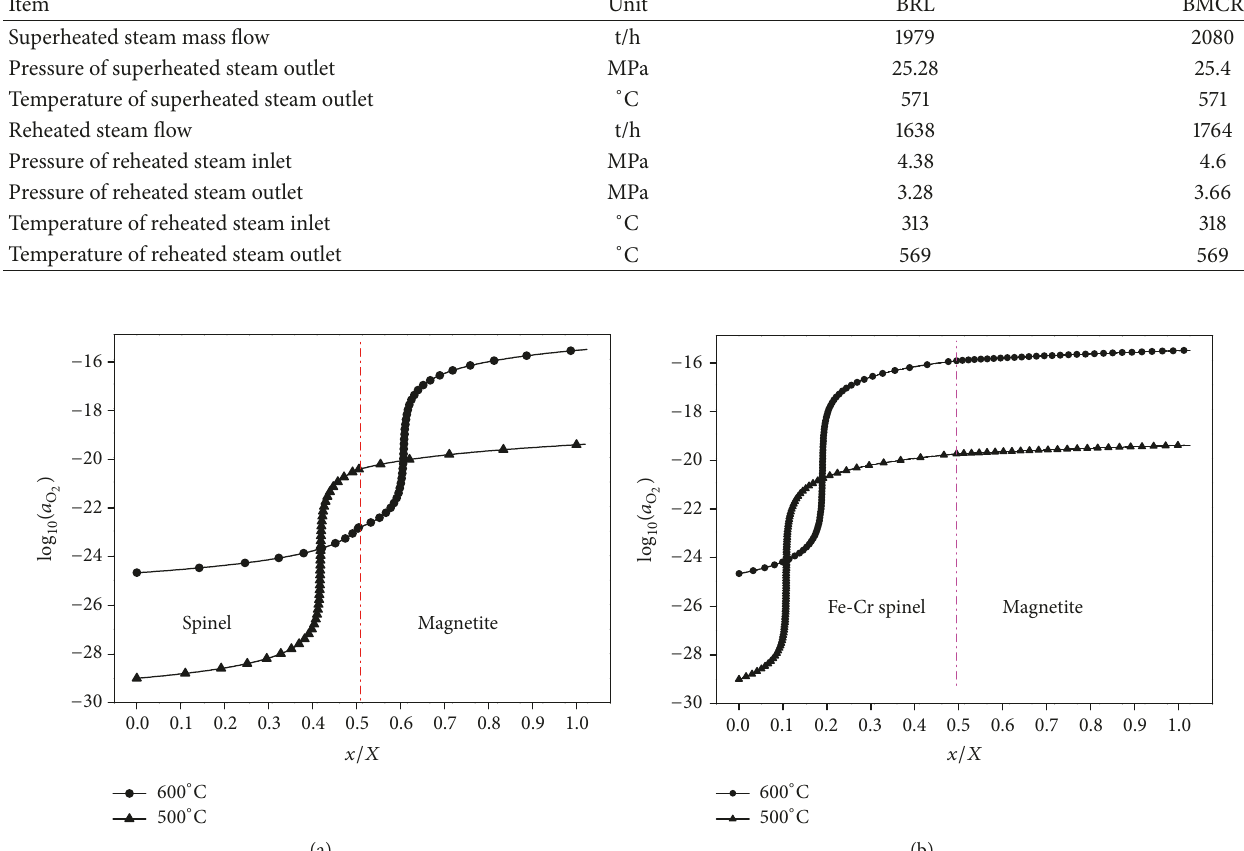
Figure 5: The calculation oxygen activity in the duplex scale formed on NF616 (a) and HCM12A (b) as a function of normalized position.